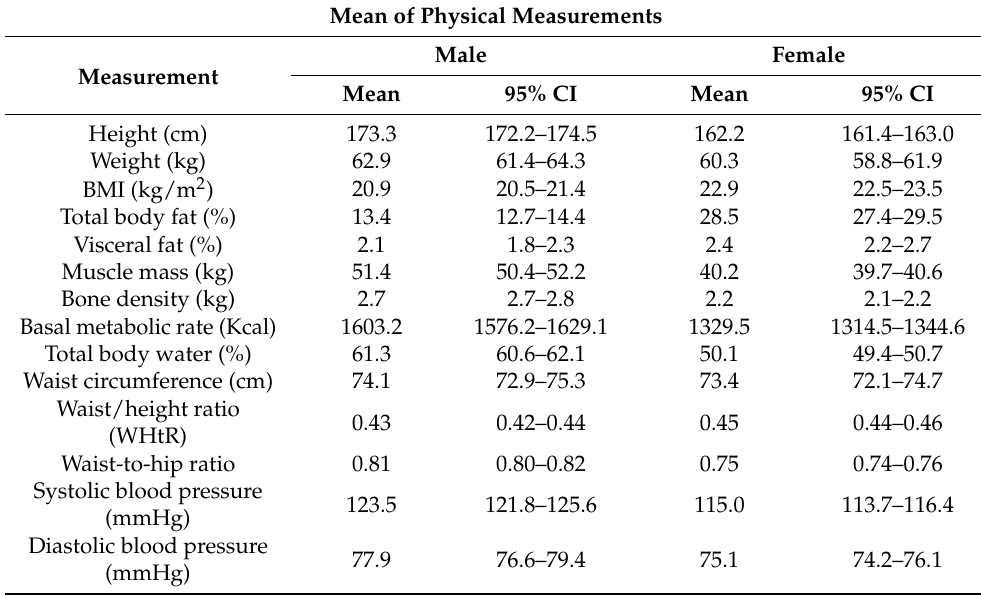
Table 2. Mean of participants physical